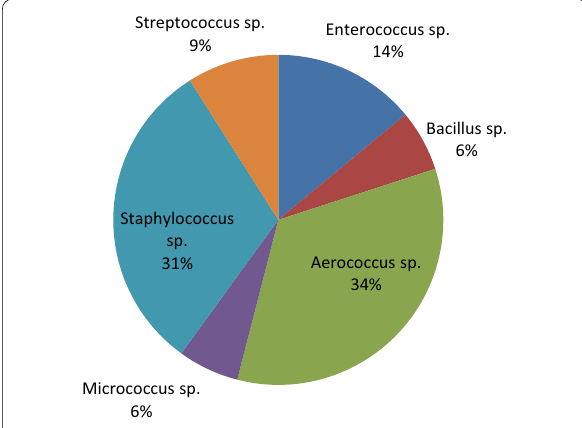
Fig. 2 Variation in bacteria groups producing black pigment on BEA